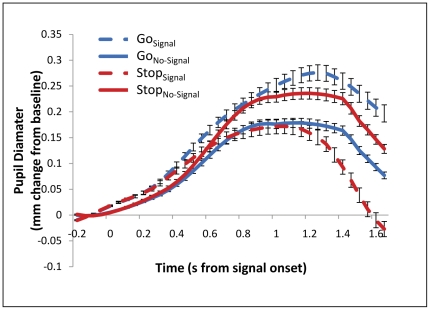
Patterns of mental effort assessed via pupillometry indicate that effort matches demands on context-monitoring, not stopping, and is modulated by the relevance of the infrequent stimulus to the planned response.In particular, stopping a response (StopSignal trials) was associated with more mental effort was required by monitoring for the appearance of stimuli that would demand stopping (StopNo-Signal trials) than by stopping itself (StopSignal trials) or by monitoring for the appearance of stimuli that would demand an additional act of going (GoNo-Signal trials).